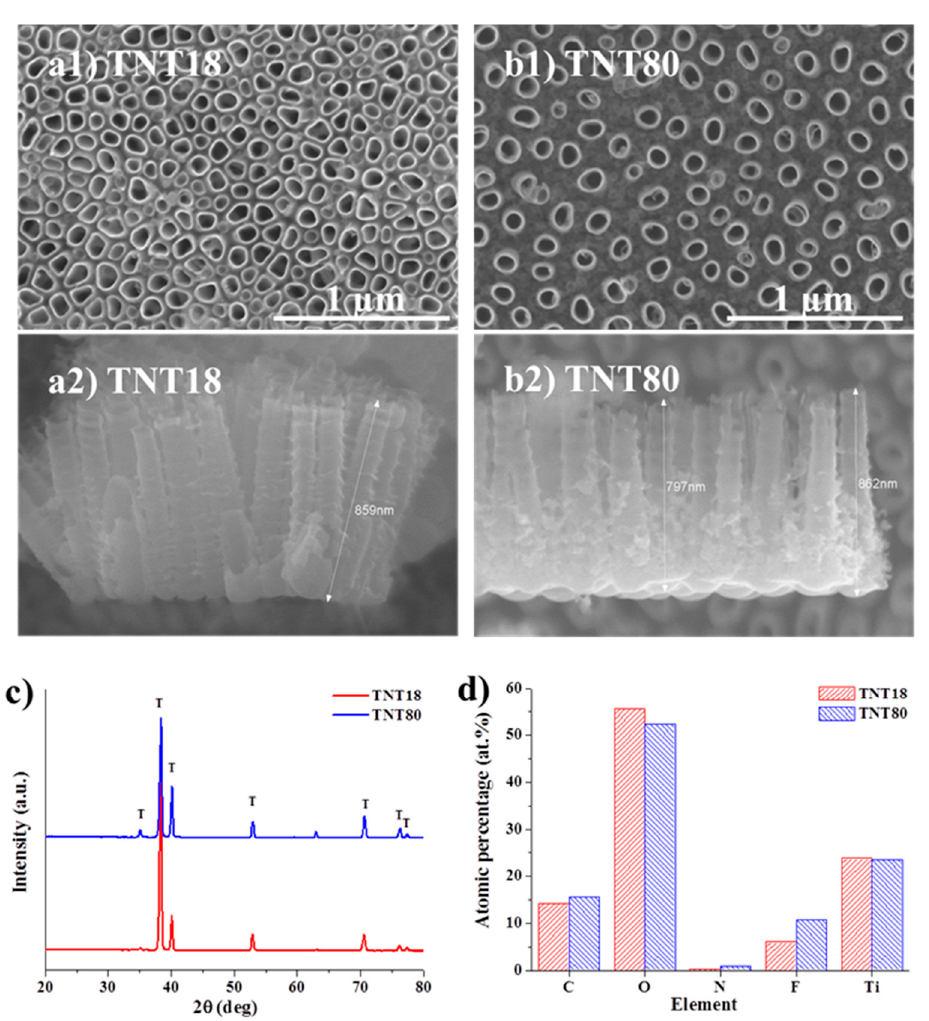
Figure 1. Top view and cross section SEM images of ( a1 , a2 ) TNT18, ( b1 , b2 ) TNT80. ( c ) XRD patterns of as-formed TiO 2 nanotubes (TNT18, TNT80); ( d ) Atomic percentage data computed from X-ray photoelectron spectroscopy (XPS) measurements for the two di ff erent nanotubular structures.